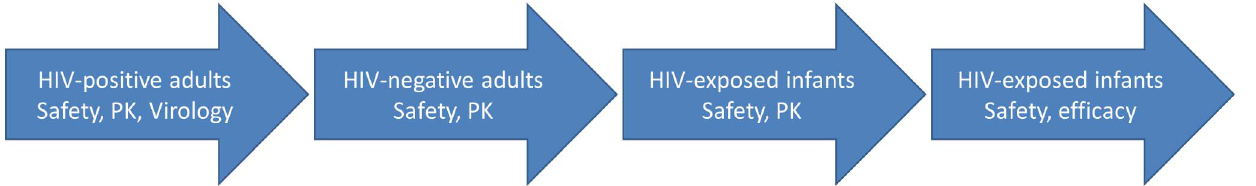
Figure 2. One possible clinical pathway for testing monoclonal antibodies in infants. Safety, pharmacokinetics (PK), and biological effect on virus populations are initially assessed in HIV-positive adults. Dosing is further refined in studies in HIV-negative adults and infants. This information is used to design an efficacy study in HIV-exposed infants as an adjunct to standard ARV treatment and prophylaxis.